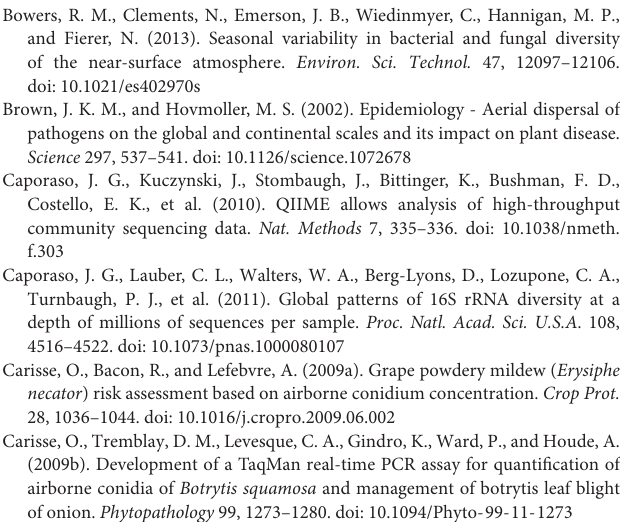
TABLE S2 | Weather data on the days of sampling on the three sampling locations, Rothamsted, UK, Slagelse, DK, and Wageningen, NL. Daily precipitation and mean temperatures are given. TABLE S3 | Observed species at the different locations. Significance of differences was tested using the two-sided Student’s two-sample t -test. TABLE S4 | Primer and probes: (a) developed probe sequence (Kim and Knudsen, 2011) was modified for the reporter dye, (b–d) developed probe sequences (Barnes and Szabo, 2007) were modified with a ZEN component and quenching IABkFQ dye, (e) primers and probe (Waalwijk et al., 2004), (f)